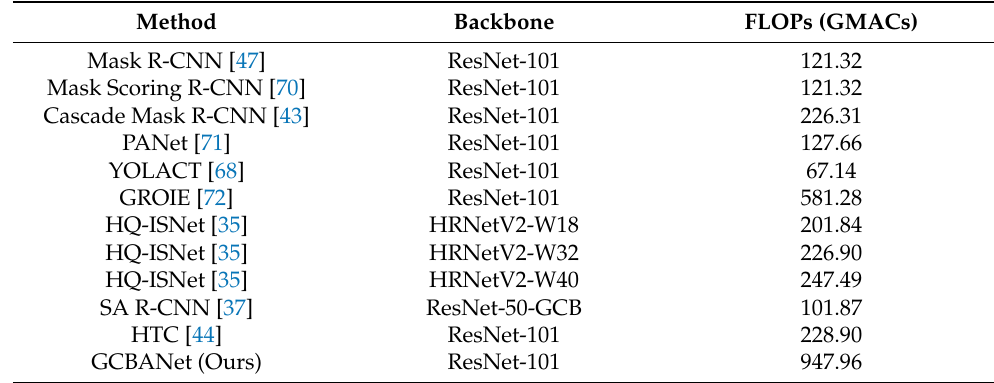
Table 1. Computational complexity calculations of different methods. Here, we adopt the floating point of operations (FLOPs) to measure calculations whose unit is the giga multiply add calculations (GMACs) [69].